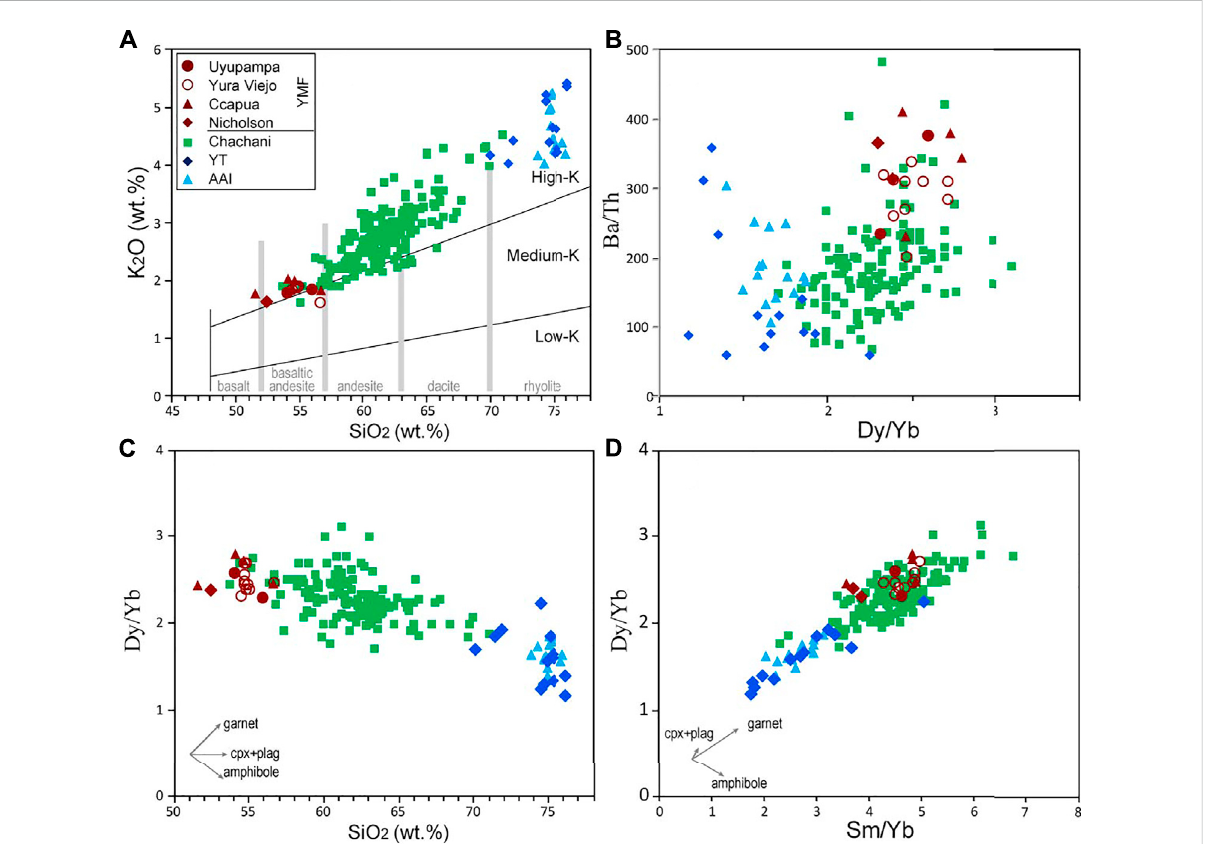
FIGURE 11 SiO 2 versusK 2 Odiagram(afterPeccerilloandTaylor,1976; (A) ,andtraceelementsignatures (B , C , D) intheYuraMonogeneticFieldrocksforthe purposeofcomparisonwithavailabledatasetsofnearbyYuraTuff,ArequipaAirportIgnimbriteandChachanivolcanicCluster(Paquereau-Lebtietal., 2006; Mamani et al., 2010; Aguilar et al., 2022).The inset trendsof evolution in (C) and (D) were taken from Wörner et al. (2018). Cpx: clinopyroxene, plag: